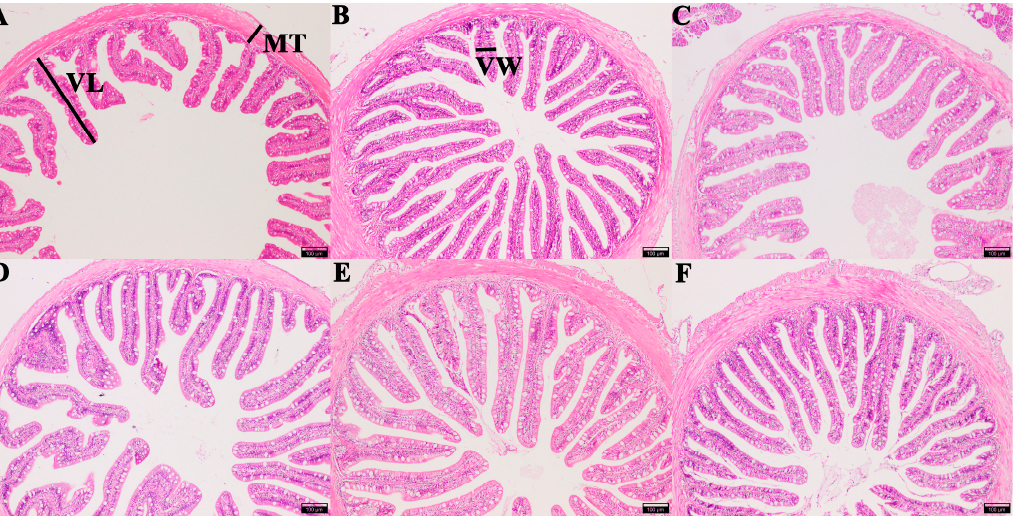
Values are expressed as means ± SEM; Mean values in the same column with different superscript letters are significantly different ( p < 0.05); CON, control; FOS, fructooligosaccharides; GLU, β -glucan; CTS, chitosan; MOS,